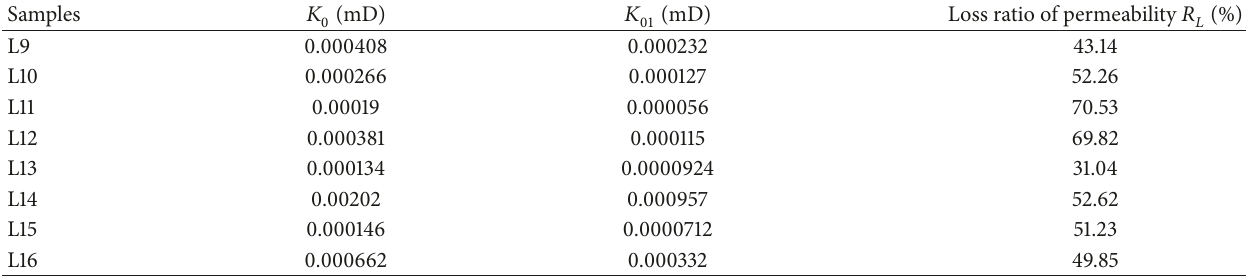
Table 4: The permeability change after the samples go through the process of loading pressure and unloading pressure.